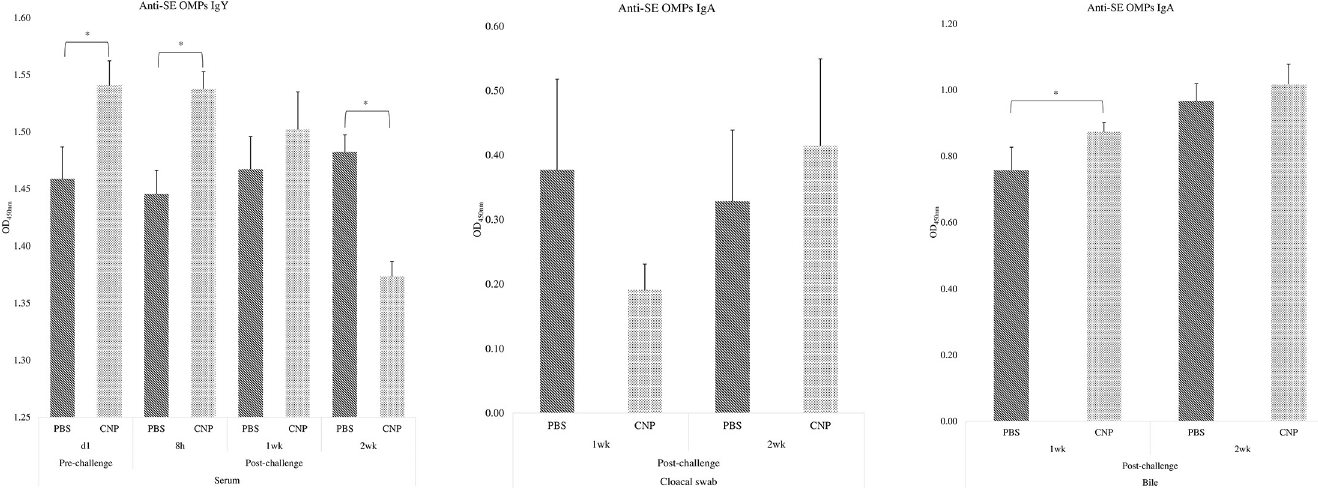
Fig 1. Anti-SE OMPS IgY/IgA in serum, cloacal swab, and bile of chickens vaccinated with in-ovo CNP. At embryonic d18, broiler eggs were vaccinated with either PBS (control) or 1000 μ g CNP vaccine. At d7 of age, birds were challenged with live SE (1.0 × 10 9 CFU/bird). Blood, cloacal swabs, and bile samples were collected pre- and post-challenge and analyzed for anti- Salmonella antigen-specific IgY and IgA levels by ELISA. Results were reported as average optical density (OD) values. A– Serum OMPs IgY; B–Cloacal swab OMPs IgA; C–Bile OMPs IgA. Data analyzed by parametric Student t-test; Means+SEM.Bars. n = 6. " � " means P <